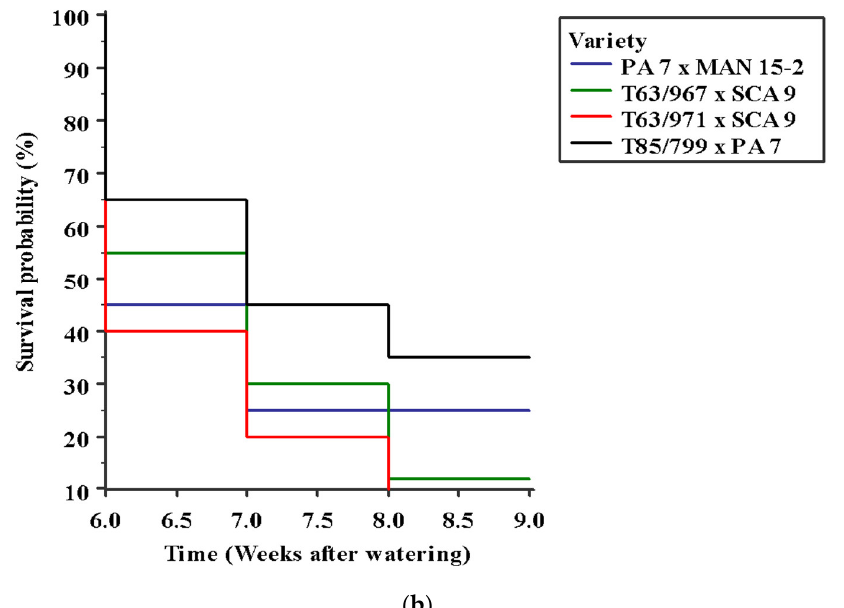
Figure 10. Survival curves of cocoa seedlings under water stress estimated using Kaplan–Meier’s method ( a ) effect of potassium, log-rank test p = 0.040; ( b ) effect of genotypes, log-rank test p = 0.2301. K refers to Muriate of potash applied per plant. Table 7. Hazard ratios from the Kaplan–Meier survival analyses for cocoa seedlings under soil water stress conditions as affected by variety and potassium application in experiment 1.